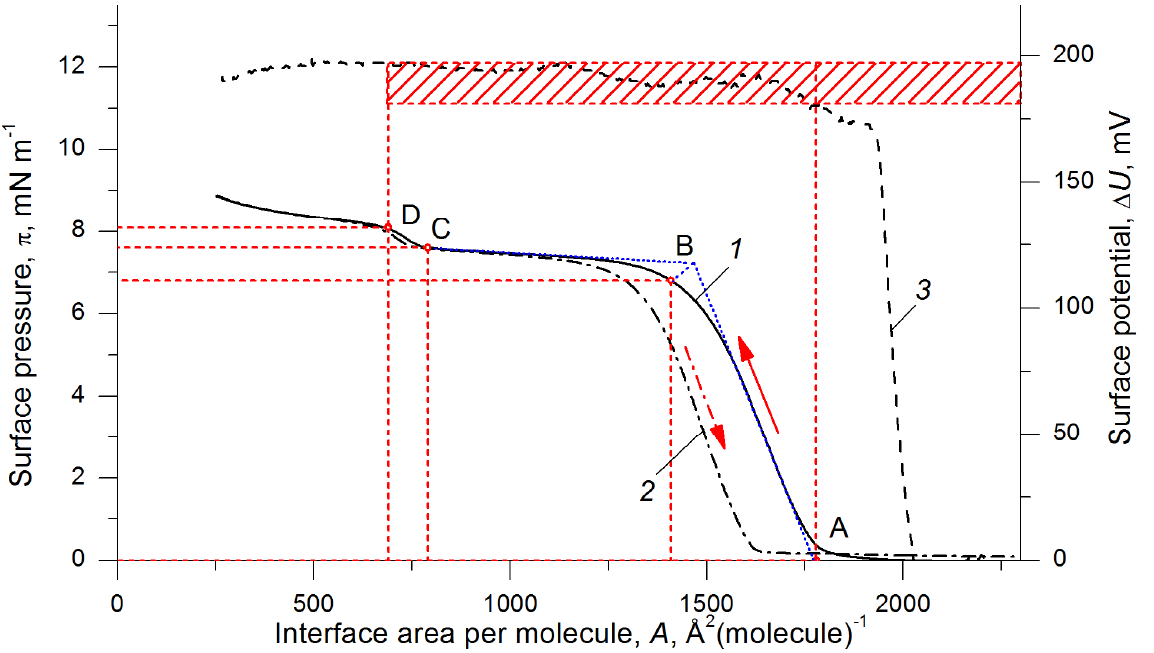
Figure 10. π -A ( 1 , 2 ) and Δ U-A ( 3 ) compression ( 1 , 3 ) and expansion ( 2 ) isotherms of Me 4 -15 Langmuir layer. T = 20 °C. Letters A–D denote characteristic points on the surface pressure isotherm.